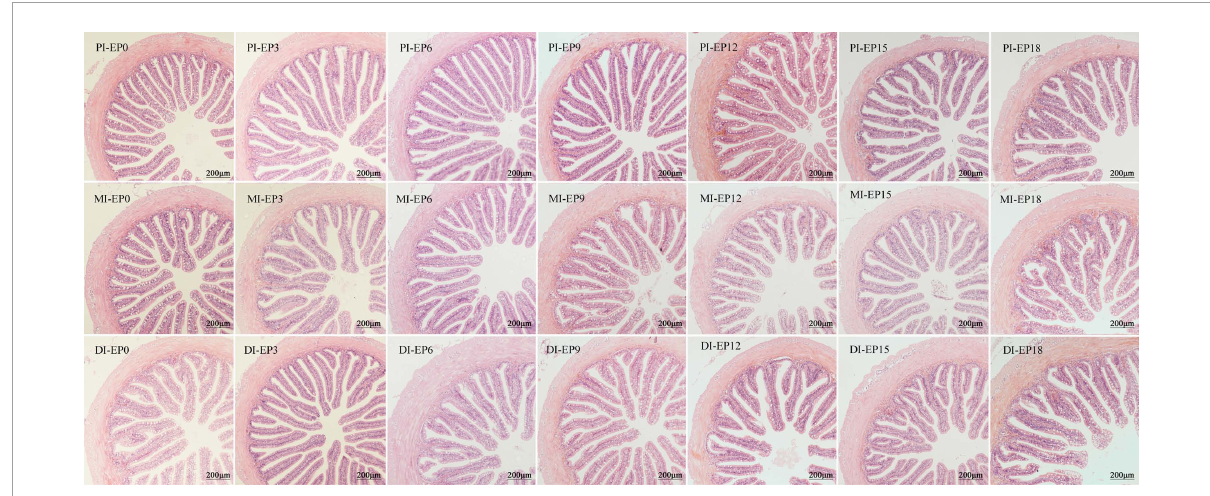
FIGURE2 Light microscopy (20 × ) of the proximal intestine (PI), mid-intestine (MI), and distal intestine (DI) morphology of hybrid groupers fed with diets. Scale bar: 200 µ m.